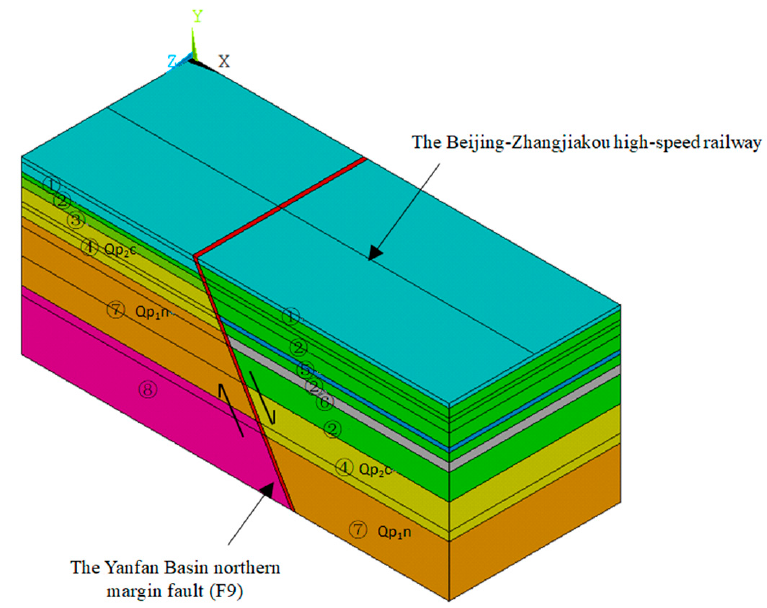
Figure 7. The 3D geological model considering the fault.